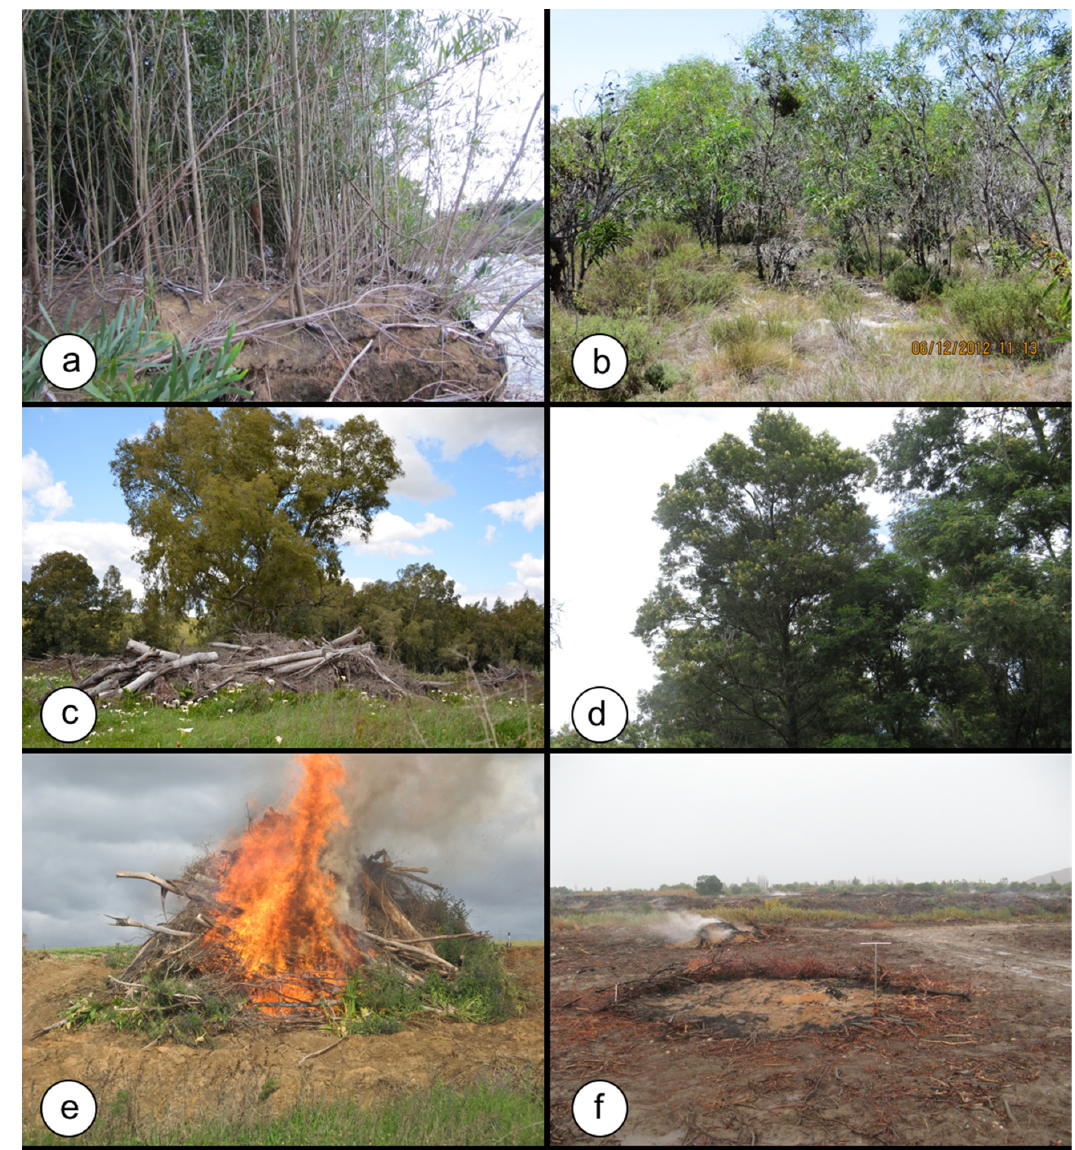
Figure 5. Examples of invasive alien plants in the fynbos biome. ( a ) Extensive invasion of riparian zones by Acacia saligna (photo: E Slabbert). ( b ) A. saligna growth in the Blaauwberg Nature Reserve park (photo: E Slabbert). ( c ) Mature Eucalyptus camaldulensis growing in a riparian zone along the Berg River at Hermon, with a large pile of alien invasive biomass in the foreground (photo: T Maubane). ( d ) A large Acacia mearnsii tree along the Breede River at Rawsonville (photo: T Maubane). ( e ) Burning piles of invasive alien plants during slash and burn removal (photo: S Jacobs). ( f ) The aftermath of burned slash piles, which in some cases may result in permanent burn scars (photo: T Maubane).